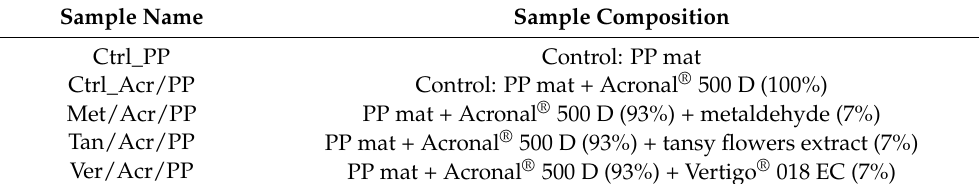
Table 2. List of sample